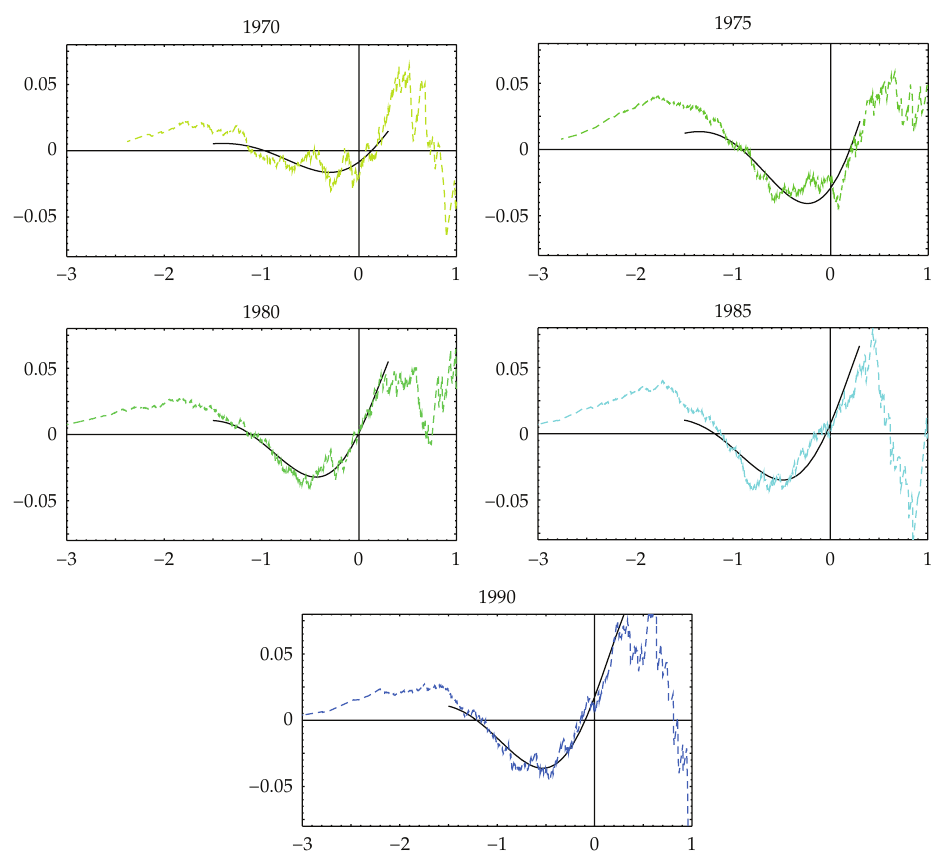
Figure 7: Di ff erence between the rank size and the log-normal fits for the same years as in Figure 6. The black curves are the fits for the range x ∈ (cid:4) − 1 . 5 , 0 . 3 (cid:5) , where x is the the horizontal coordinate (cid:3) log (cid:3) netcap (cid:6)(cid:6) , with ae x sin (cid:3) kx (cid:10) m (cid:6) with a,k , and m as free